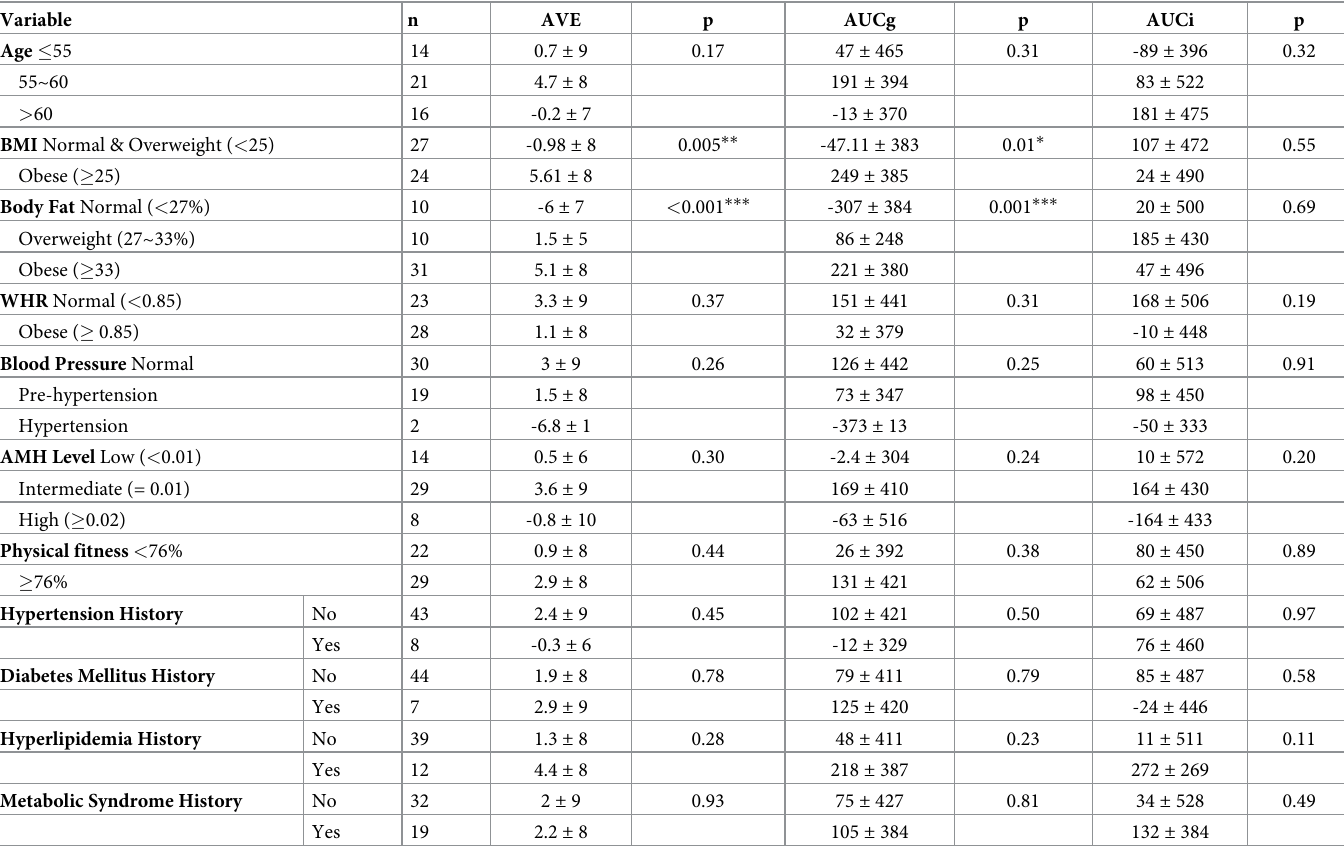
Table 5. Differences in the changes of CAR through the program based on individual characteristics of the